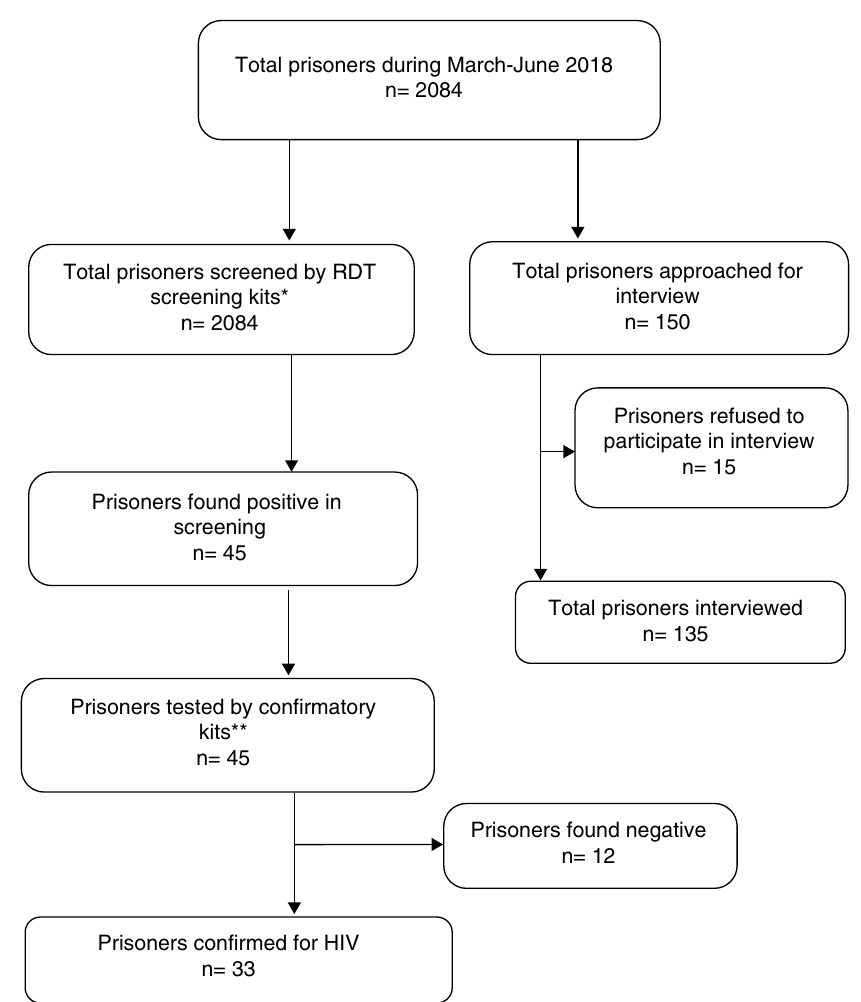
Figure 1. Flow diagram of prisoners screened and interviewed for HIV in prisons in Balochistan. *Test 1 = Alere Determine HIV-1/2 Ag/Ab Combo for detection of Antigent/Antibody, **Test 2 = Uni-Gold HIV, **Test 3 = SD Bioline HIV-1/2